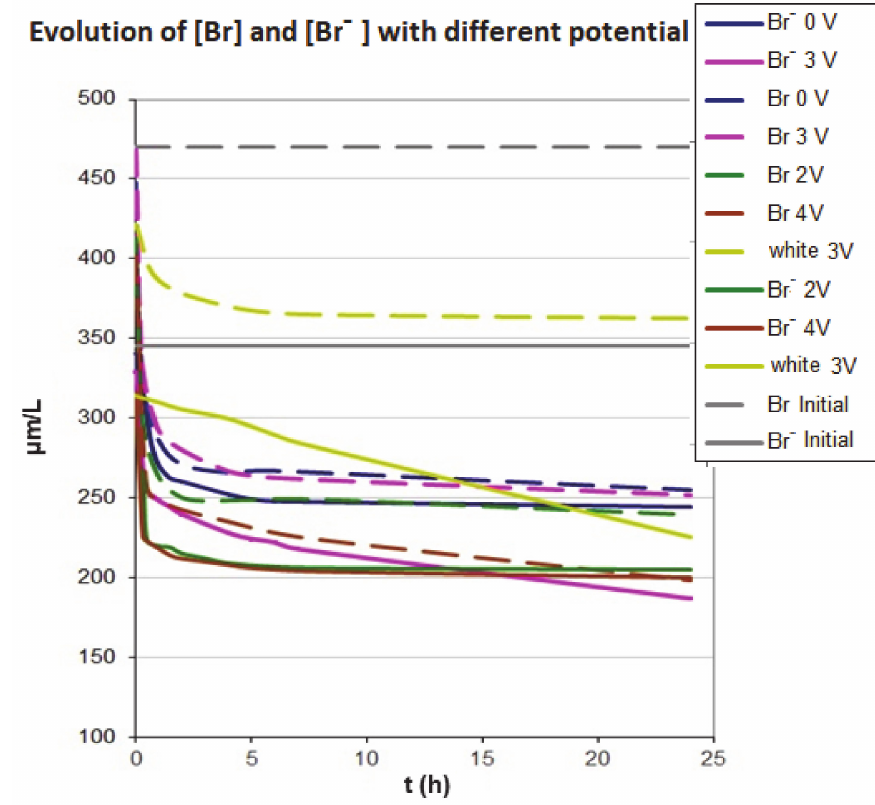
Figure 3. Variation of the bromide and total bromine at different voltages (2 V, 3 V and 4 V) under anodic conditions. The adsorption in the absence of voltage is also included. The dashed line corresponds to the total bromine and full line to the